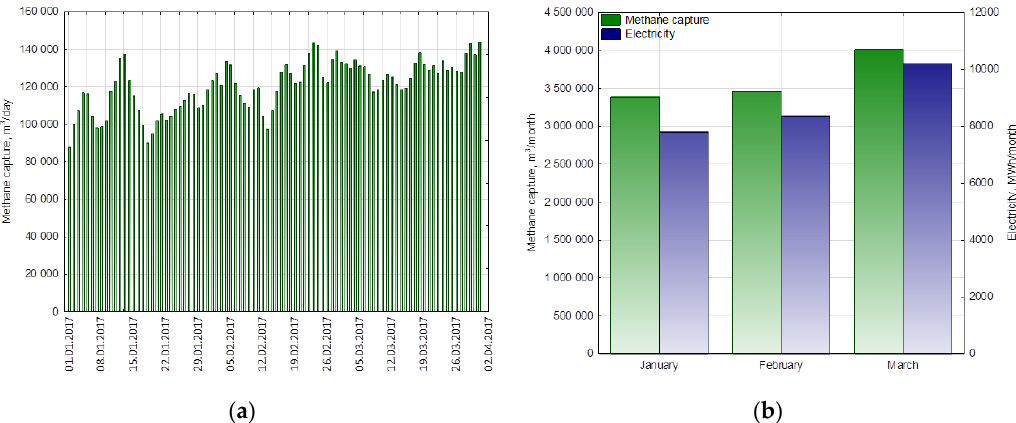
Figure 10. Variability of methane capture in the analysed period ( a ) in a daily cycle and ( b ) in a monthly cycle, taking into account electricity production.